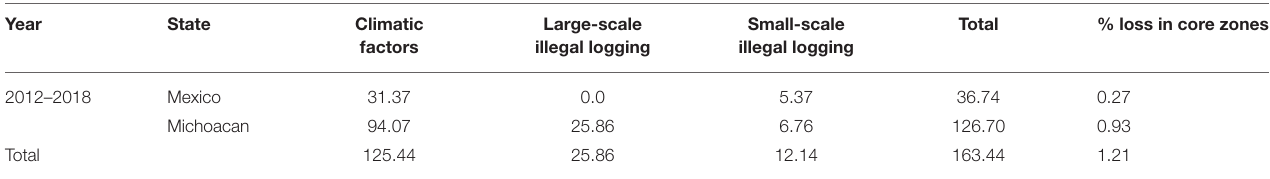
TABLE 1 | Recent forest cover loss (ha) due to climate-related factors (wind and rain), and large-scale and short-scale illegal logging in the core zones of the Monarch Butterfly Biosphere Reserve (MBBR).